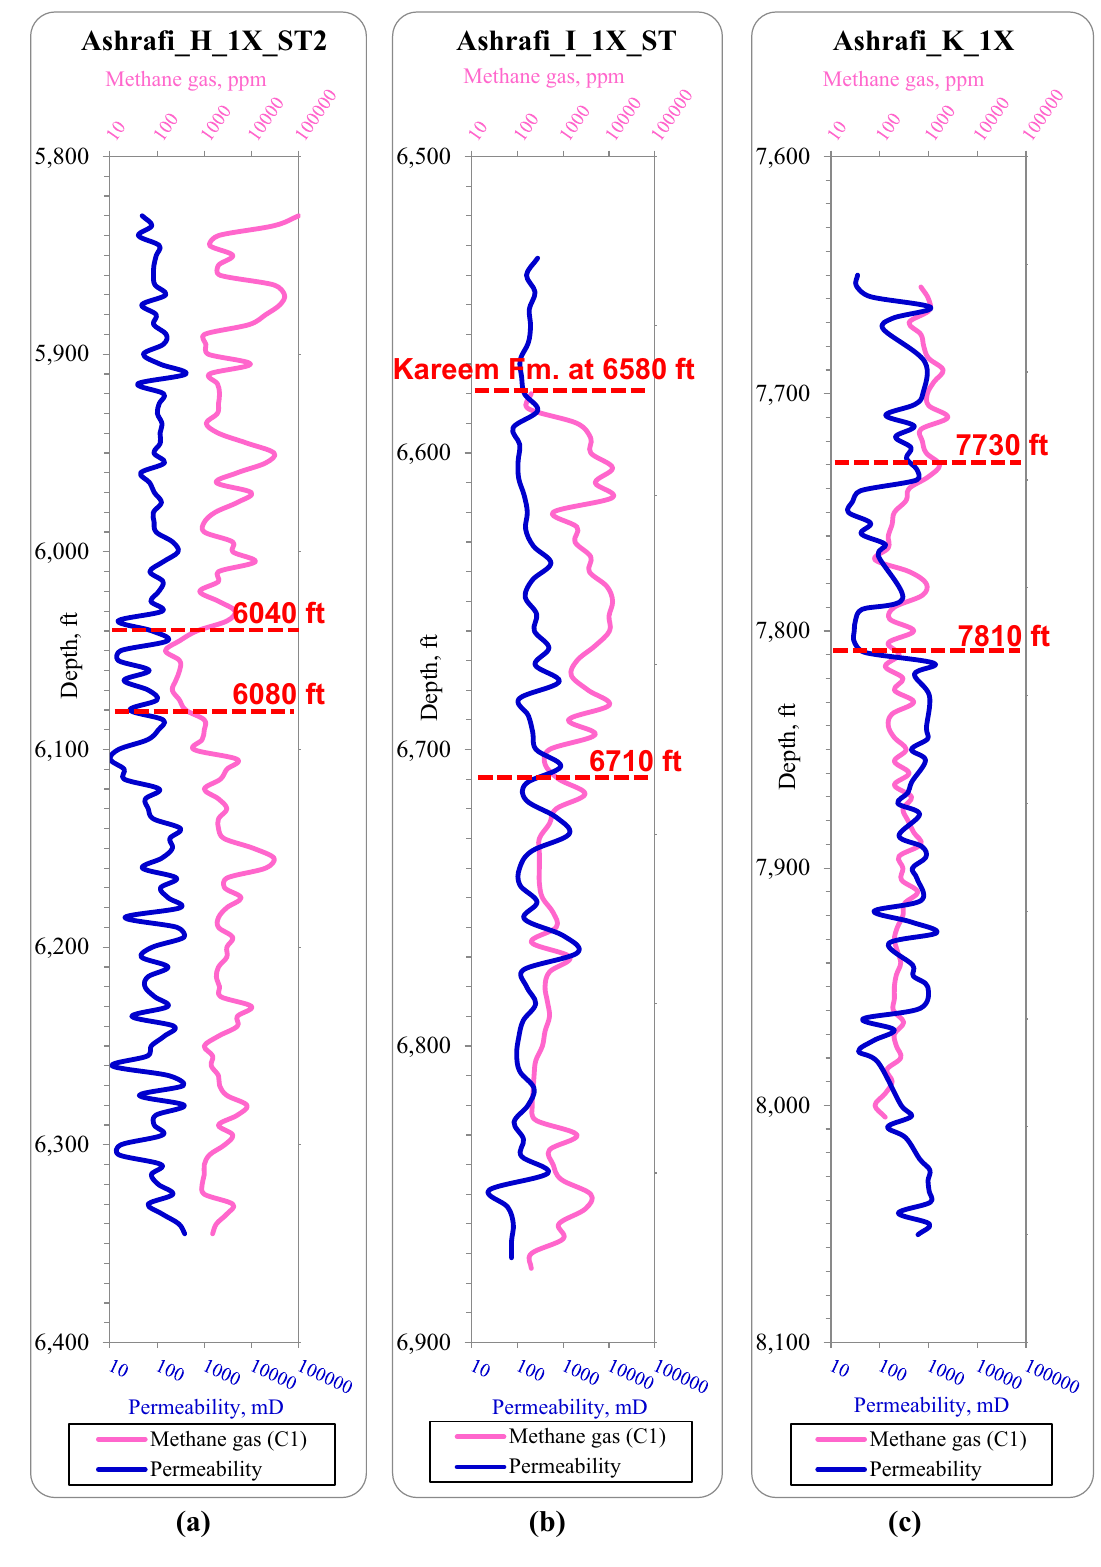
Fig. 10 The relationships between methane gas (ppm) and permeability ( K , mD) with depth a Ashrafi_H_1X_ST2, b Ashrafi_I_1X_ST, and c Ashrafi_K_1X. The red dashed lines represent the possible overpressure